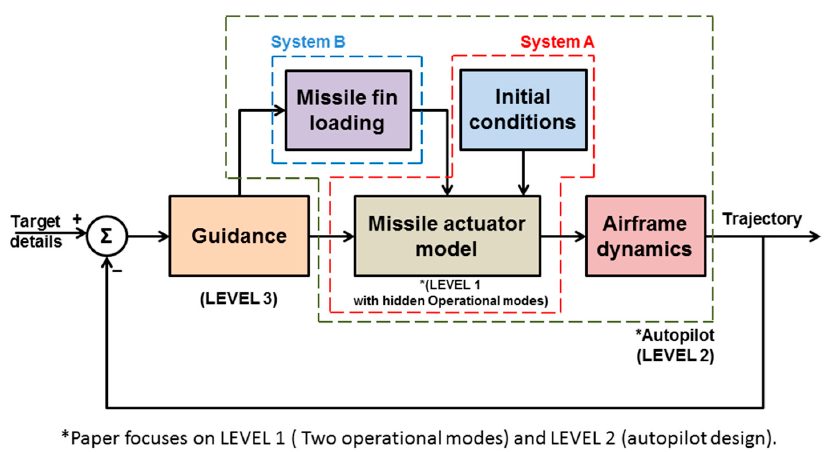
Figure 1. Missile guidance architecture (Levels 1–3).